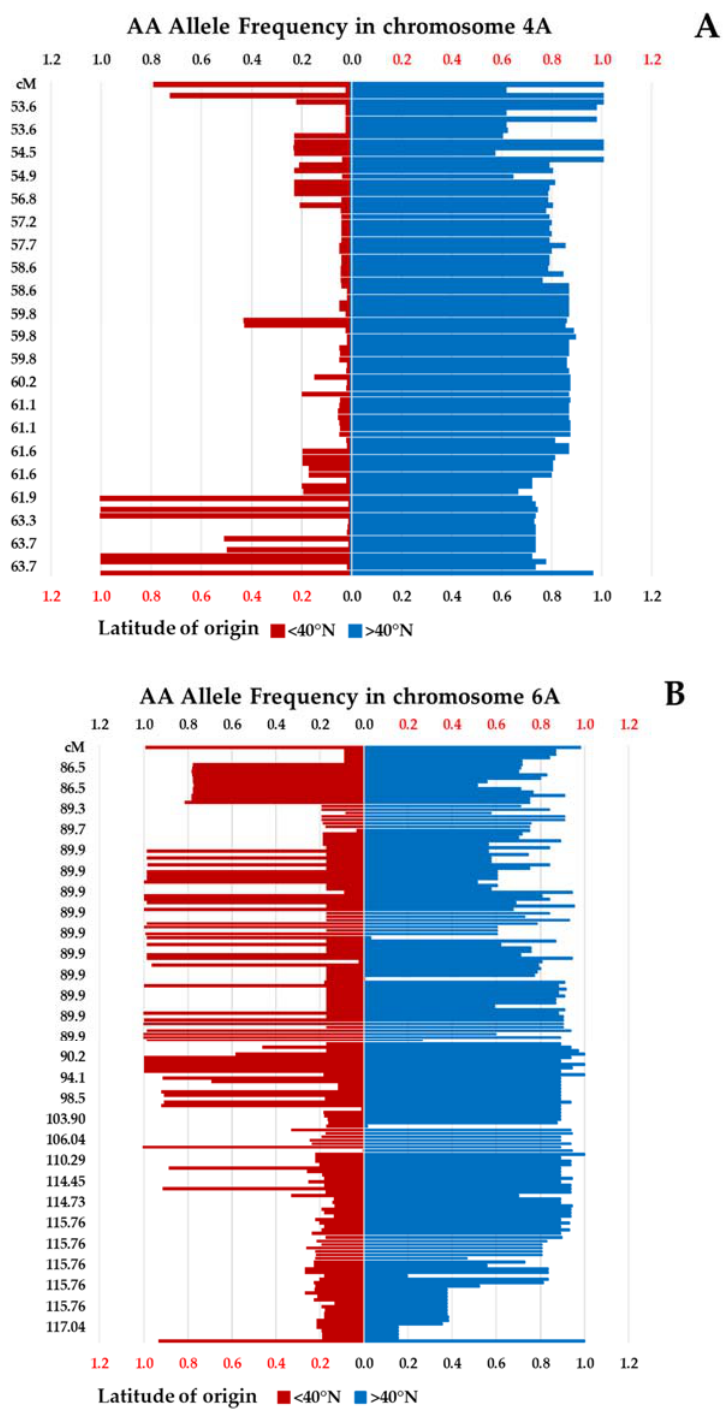
Figure 2. Linkage block analysis for the distribution of allele frequencies of 553 winter wheat landraces from higher (>40° N) and lower (<40° N) latitudes in ( A ) chromosome 4A and ( B ) chromosome 6A.